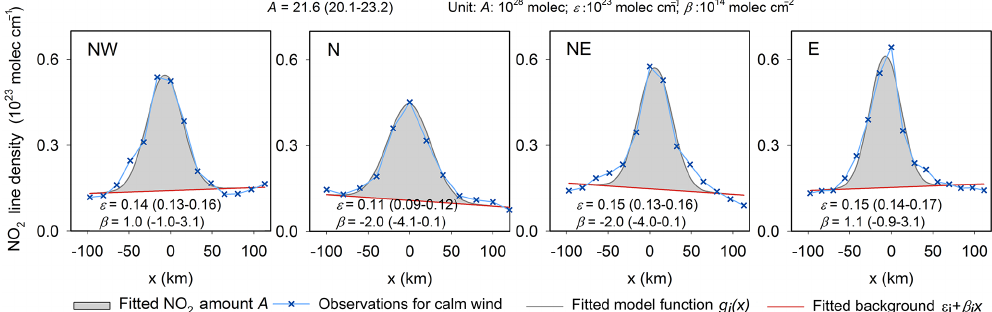
Figure 3. NO 2 line densities in Harbin for northwest, north, northeast and east directions (from left to right). Crosses: NO 2 line densities for calm winds as a function of the distance to Harbin center x . Grey line: the fit result g i (x) . Pink line: the fitted background ε i + β i x . Grey shade: the magnitude of the fitted NO 2 amount A . The number indicates A , the offset ε and the linear gradient in the background field β resulting from the least-squares fit with 95%